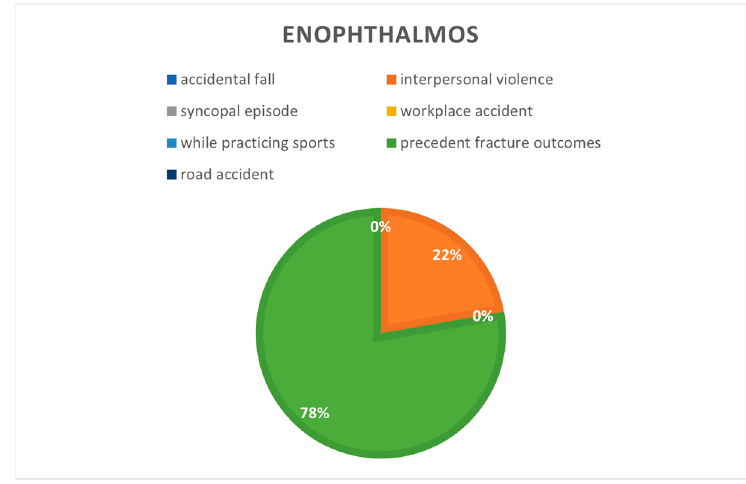
Figure 6. Enophthalmos correlated to cause of the